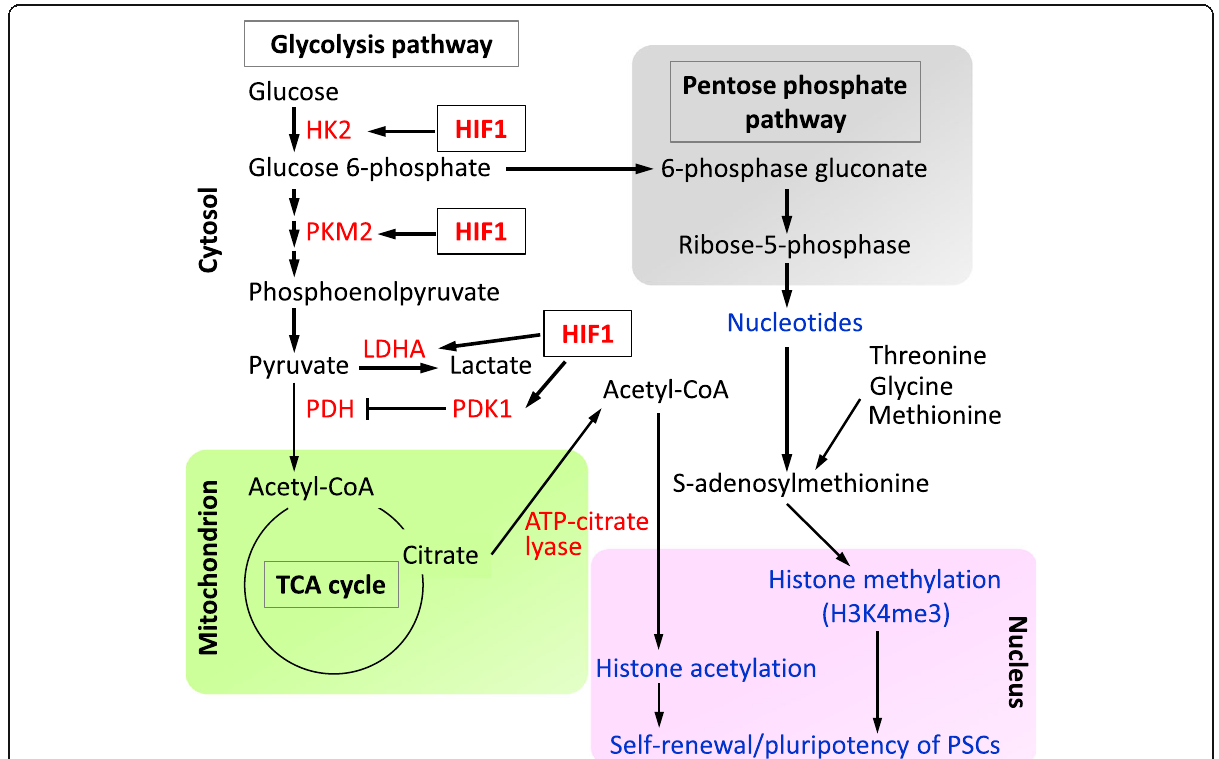
Fig 1 Glycolytic metabolism and its functional relevance in PSCs. Acetyl-CoA, acetyl-coenzyme A; ATP, adenosine triphosphate; HIF1, hypoxia- inducible factor 1; HK2, hexokinase 2; LDHA, lactate dehydrogenase; PDH, pyruvate dehydrogenase; PDK1, pyruvate dehydrogenase kinase 1; PKM2, pyruvate kinase M2; PSC, pluripotent stem